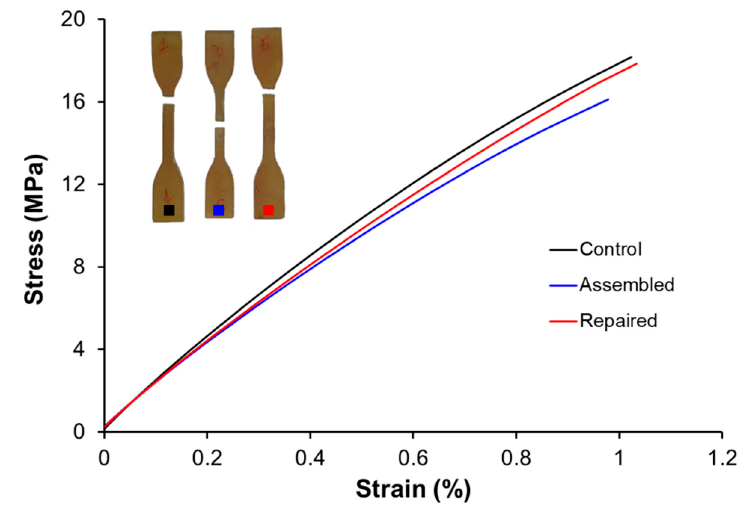
Figure 17. Stress–strain curves of FEMA 3D 25 dog-bone samples. Inset: Photographs of samples after failure.